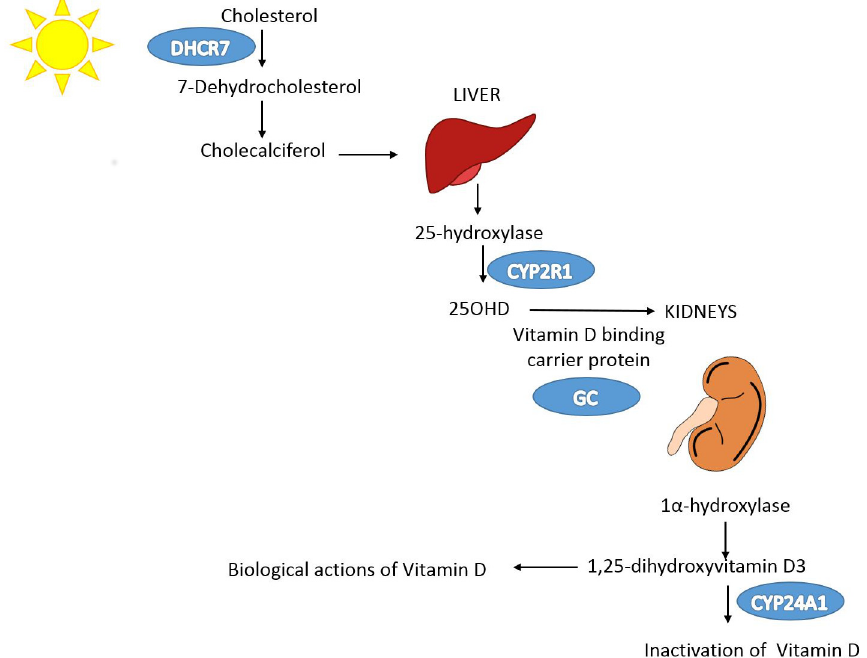
Fig 2. Vitamin D pathway. In blue are the genes containing, or in proximity to, SNPs that were genome-wide significant for 25OHD level in SUNLIGHT ( n = 33,996). The p -values for the association with 25OHD level were 1.9 × 10 − 109 for GC , 2.1 × 10 − 27 for DHCR7 , 3.3 × 10 − 20 for CYP2R1 , and 6.0 × 10 − 10 for CYP24A1 . Note that each gene plays an independent role in modulating the level of 25OHD. Kidney and liver images credit: https://openclipart.org/.